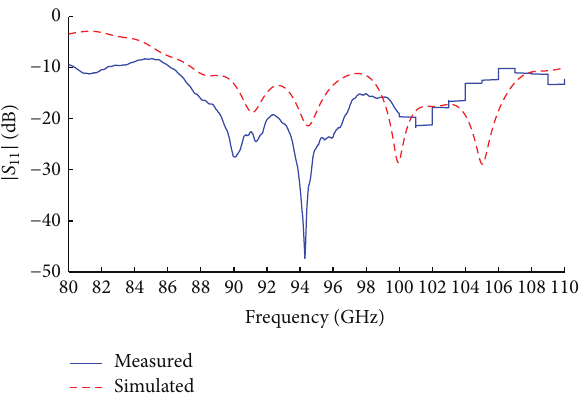
Figure 7: Measured and simulated reflection coefficient |𝑆 11 | versus frequency of proposed Quasi-Yagi dipole antenna prototype II.